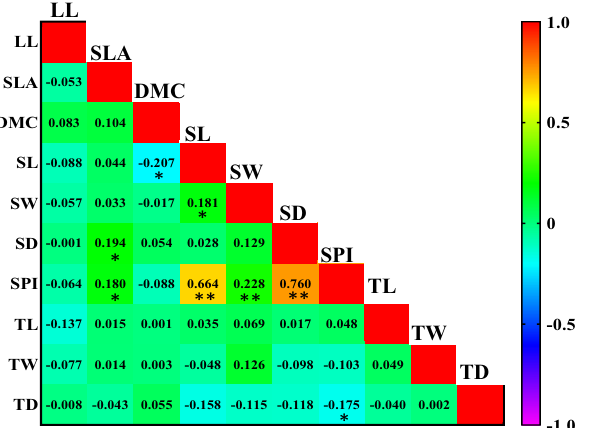
Figure 4. Pearson’s correlation coefficients between leaf morphological and anatomical traits of Quercus brantii in Mediterranean climate. Orange and yellow represent strong positive correlations. Leaf length (LL), specific leaf area (SLA), dry matter content (DMC); stomata length (SL), stomata width (SW), stomatal density (SD), stomatal pore index (SPI), trichome length (TL), trichome width (TW) and trichome density (TD). * P < 0.05; ** P < 0.01.